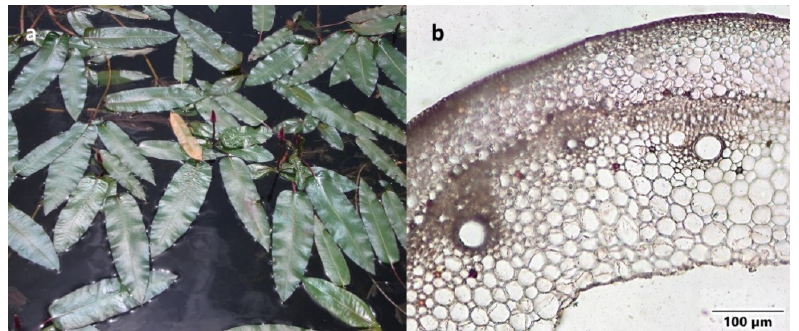
Figure 5. Polygonum amphibium L. f. natans; ( a ) natant leaves and ( b ) section of a hollow stem. Photo: Matej Holcar.